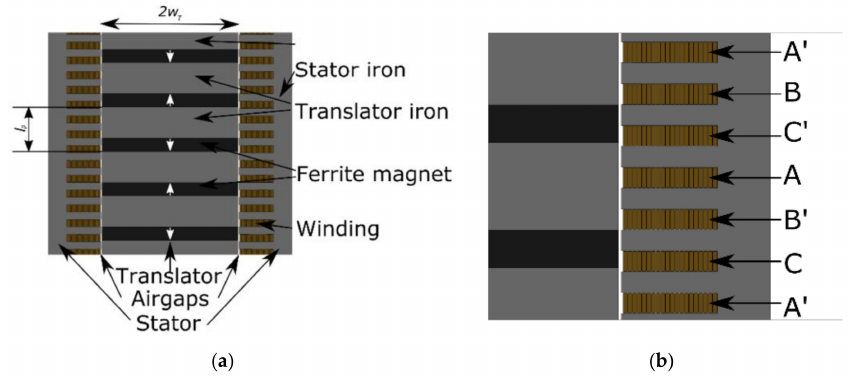
Figure 8. A cross section of the layout of the ferrite generator design, where the white arrows mark the direction of magnetization for the ferrite magnets: ( a ) The main parts of the generatnor; ad, ( b ) The winding of the phases.